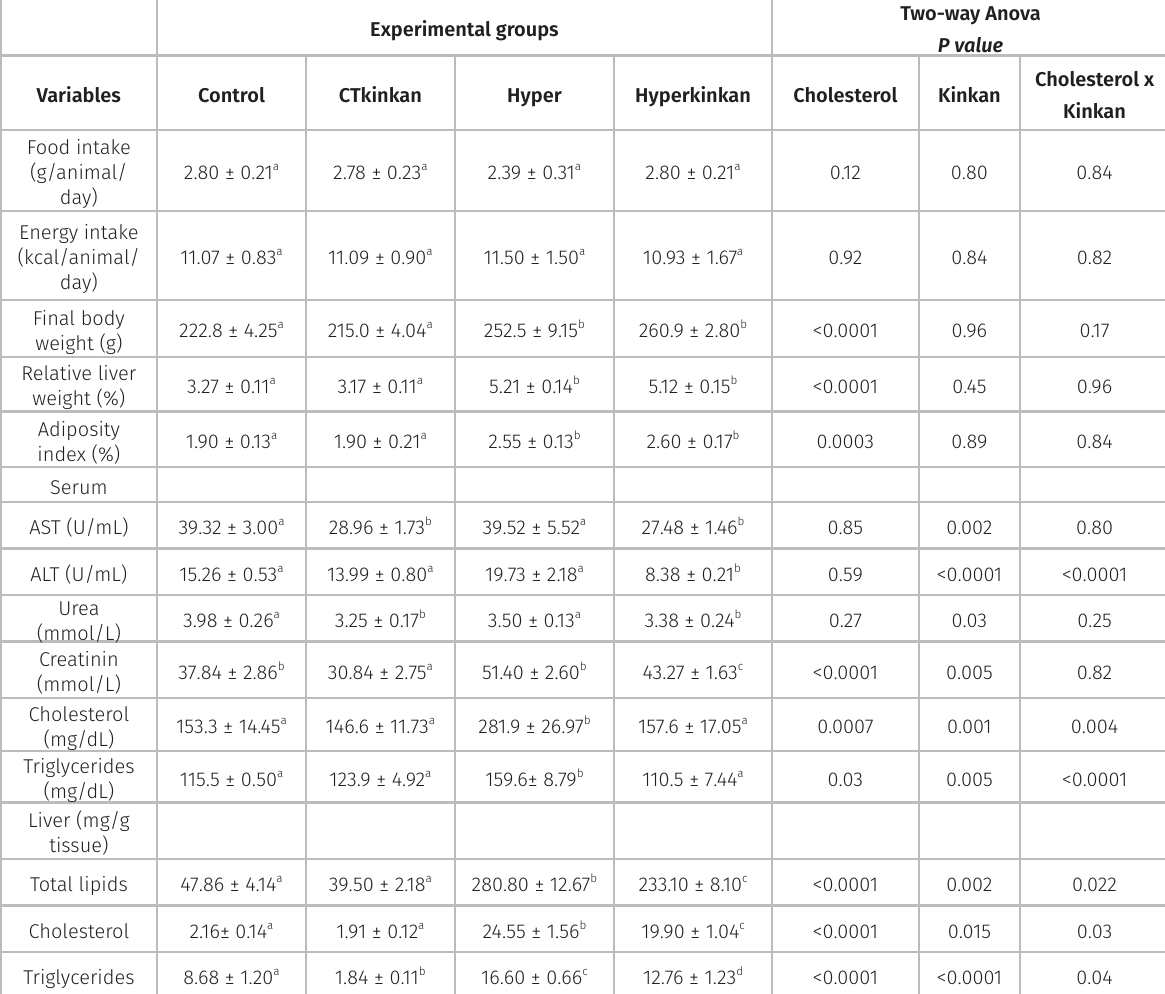
Table I. Food and energy intake, body weight, adiposity and metabolic parameters of animals fed with different